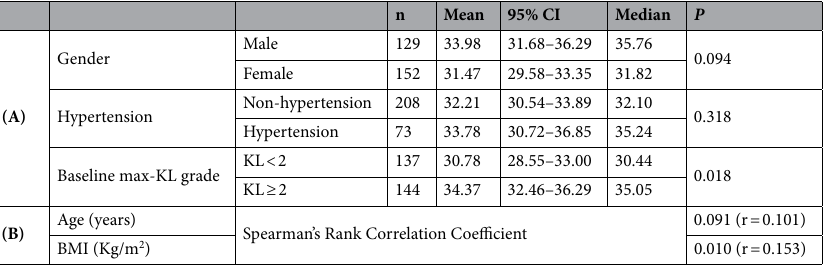
Table 2. Evaluation of the relative percentage of telomere loss after 6 years of follow-up, in peripheral blood leukocytes from individuals from the OAI cohort, in relation to parameters obtained at recruitment. (A) Comparisons performed by Mann–Whitney U-test. (B) Correlation analysis.